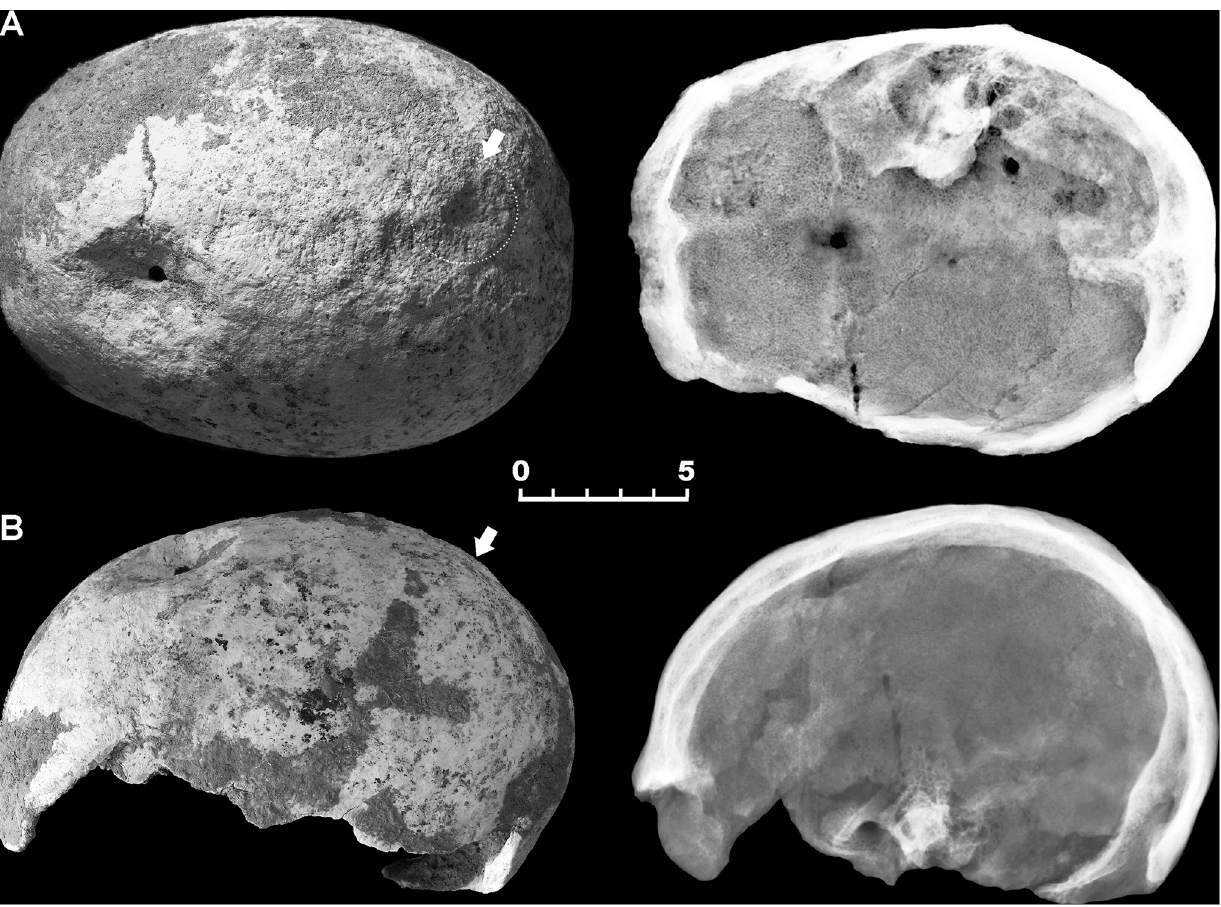
Fig 2. Double skull trephination affecting specimen 6589.1. Superior (A) and lateral (B) view and corresponding X-ray images of the skull-cap. Wide crater-like elliptical depression across the bregma, showing well-defined, irregular borders (A, B). Gross morphology and X-ray images show healing, new bone being more radiolucent and with less mature architecture compared with surrounding old bone. A further minor depression in located close to the lambda (arrows) (A, B). Scale bar equals 5 cm.